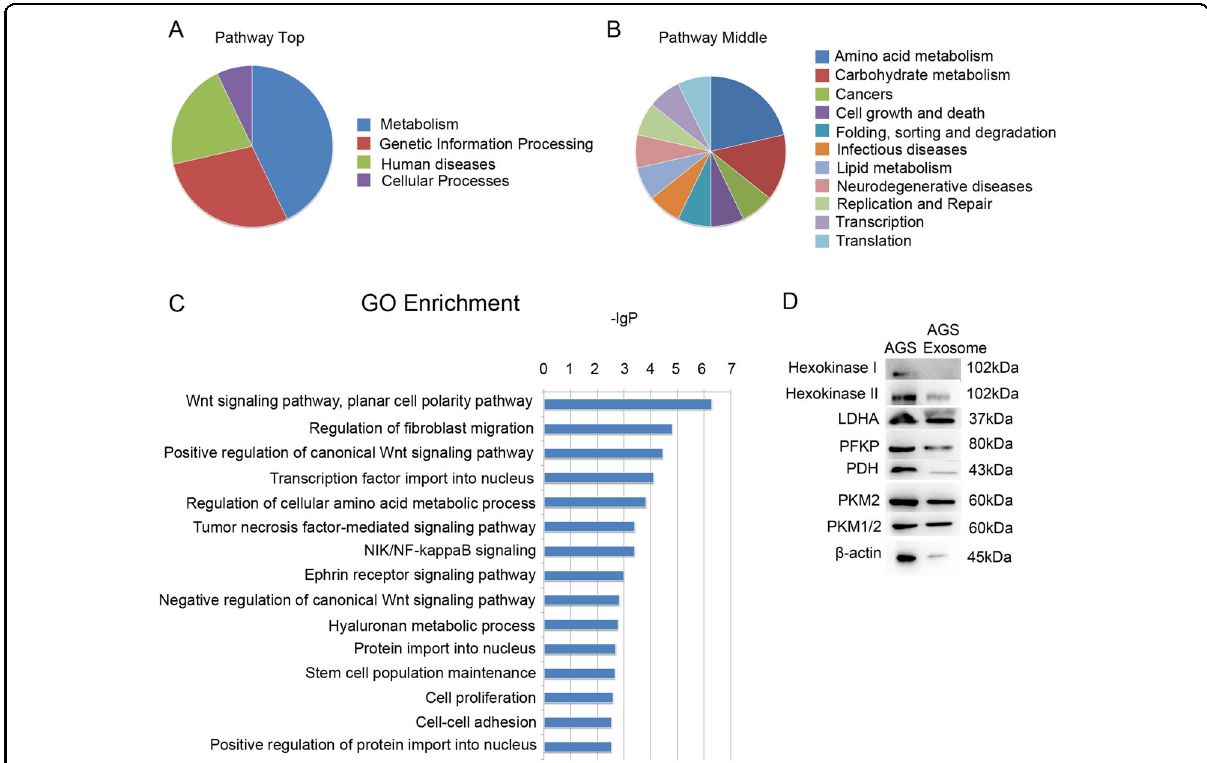
Fig. 2 The protein components of gastric cancer exosomes. A , B Pathway enrichment analysis of gastric cancer exosomes. A Pathway top. B Pathway middle. C GO enrichment analysis of gastric cancer exosomes. D Glycolysis enzymes of AGS and AGS exosomes by western